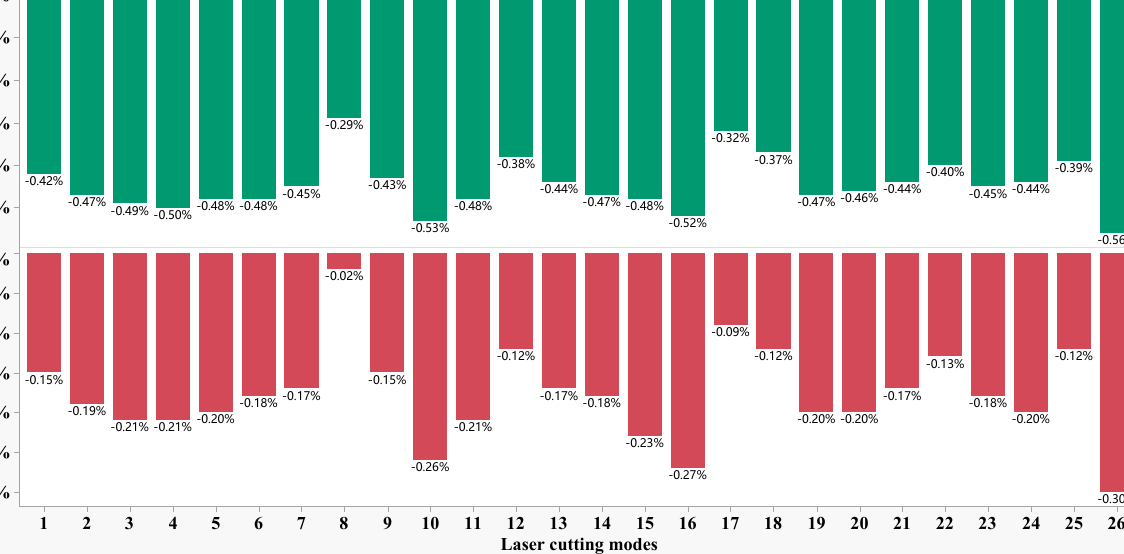
Figure 4. Δ B m distribution under the various laser cutting parameters.